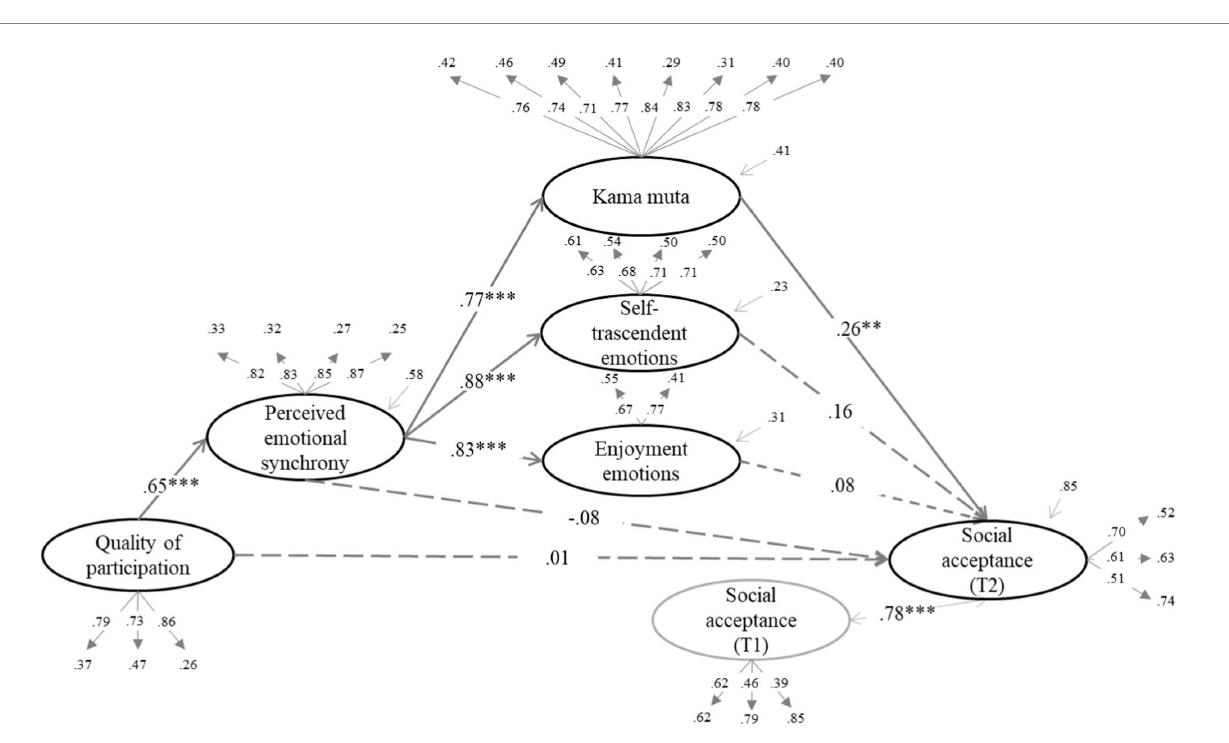
between QP and remembered well-being ( B = 0.13, SE = 0.06, p = 0.007, 95% CI [0.045, 0.286]). Therefore, we can say that PES and proximal effects also influenced the effect of QP on remembered well-being.